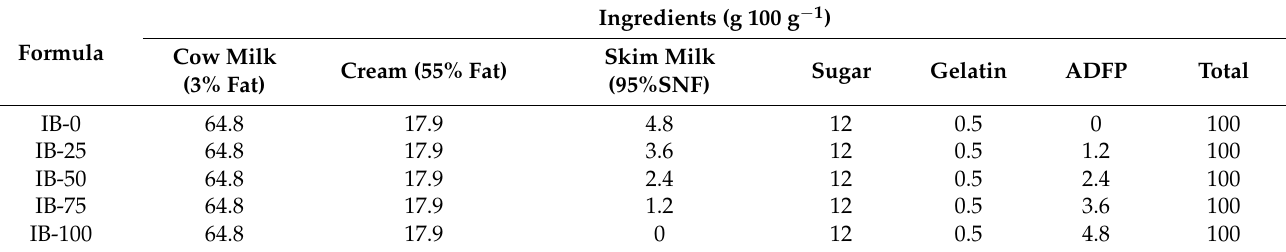
Table 1. Ingredients of different ice cream formulations incorporating